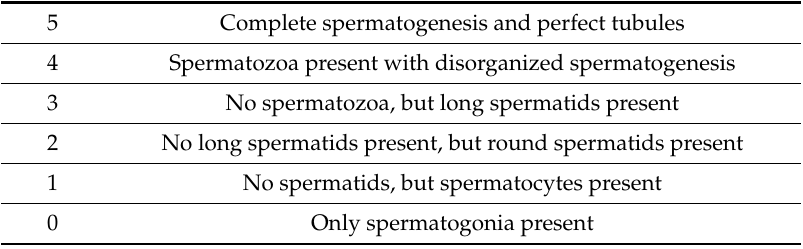
Table 1. Criteria for scoring the